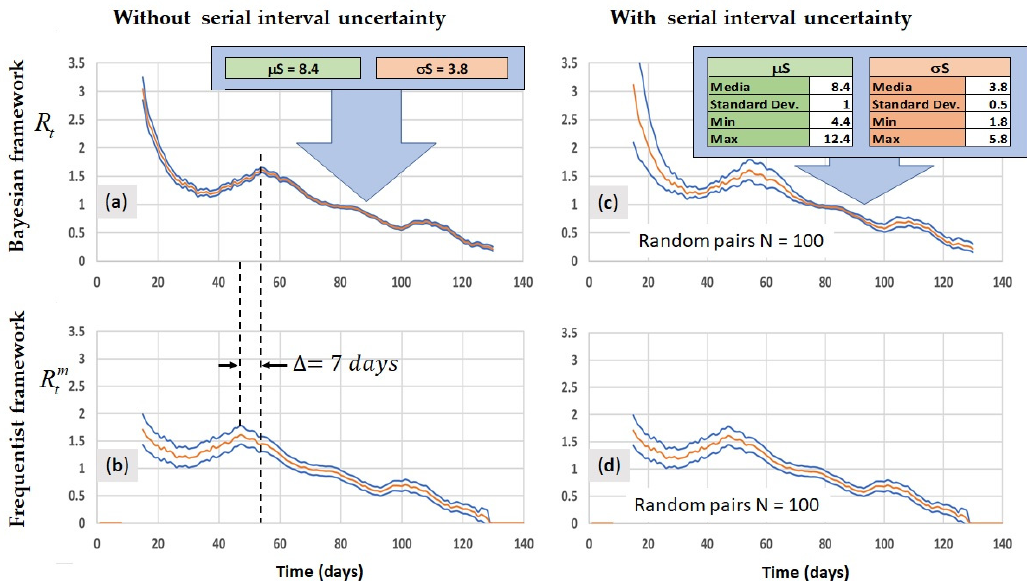
Figure 11. Instantaneous reproduction number graphs calculated by different methodologies, con- sidering confidence intervals of 95%: ( a ) Bayesian framework without serial interval uncertainty; ( b ) Frequentist framework without serial interval uncertainty; ( c ) Bayesian framework with serial interval uncertainty; and ( d ) Frequentist framework with serial interval uncertainty.